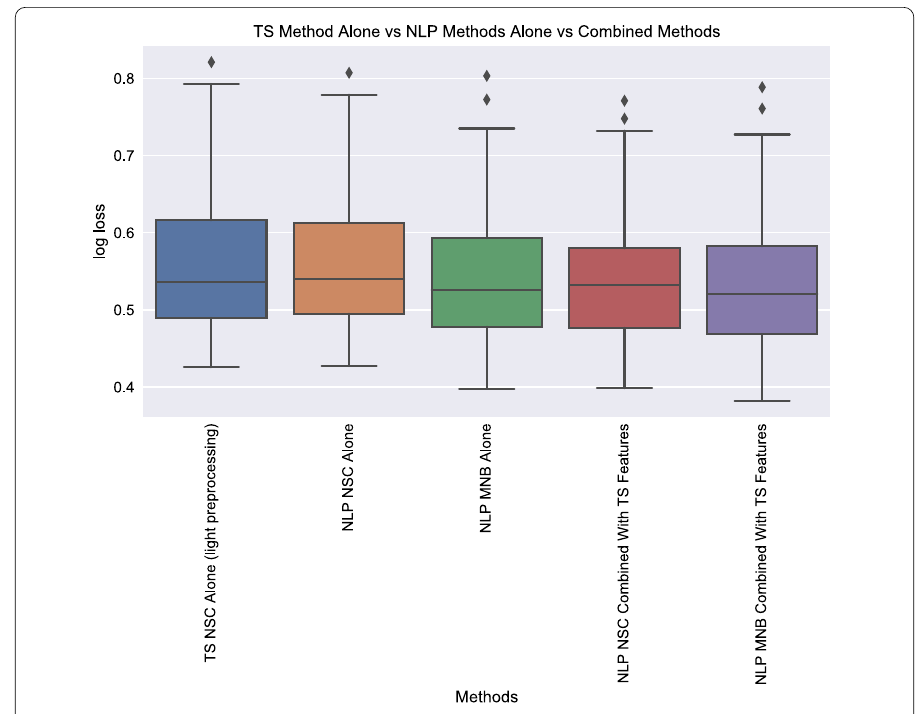
Figure 22 Distributions of the test log loss scores obtained from Time Series Method (TS NSC light preprocessing) and NLP Methods alone, and from the combined methods